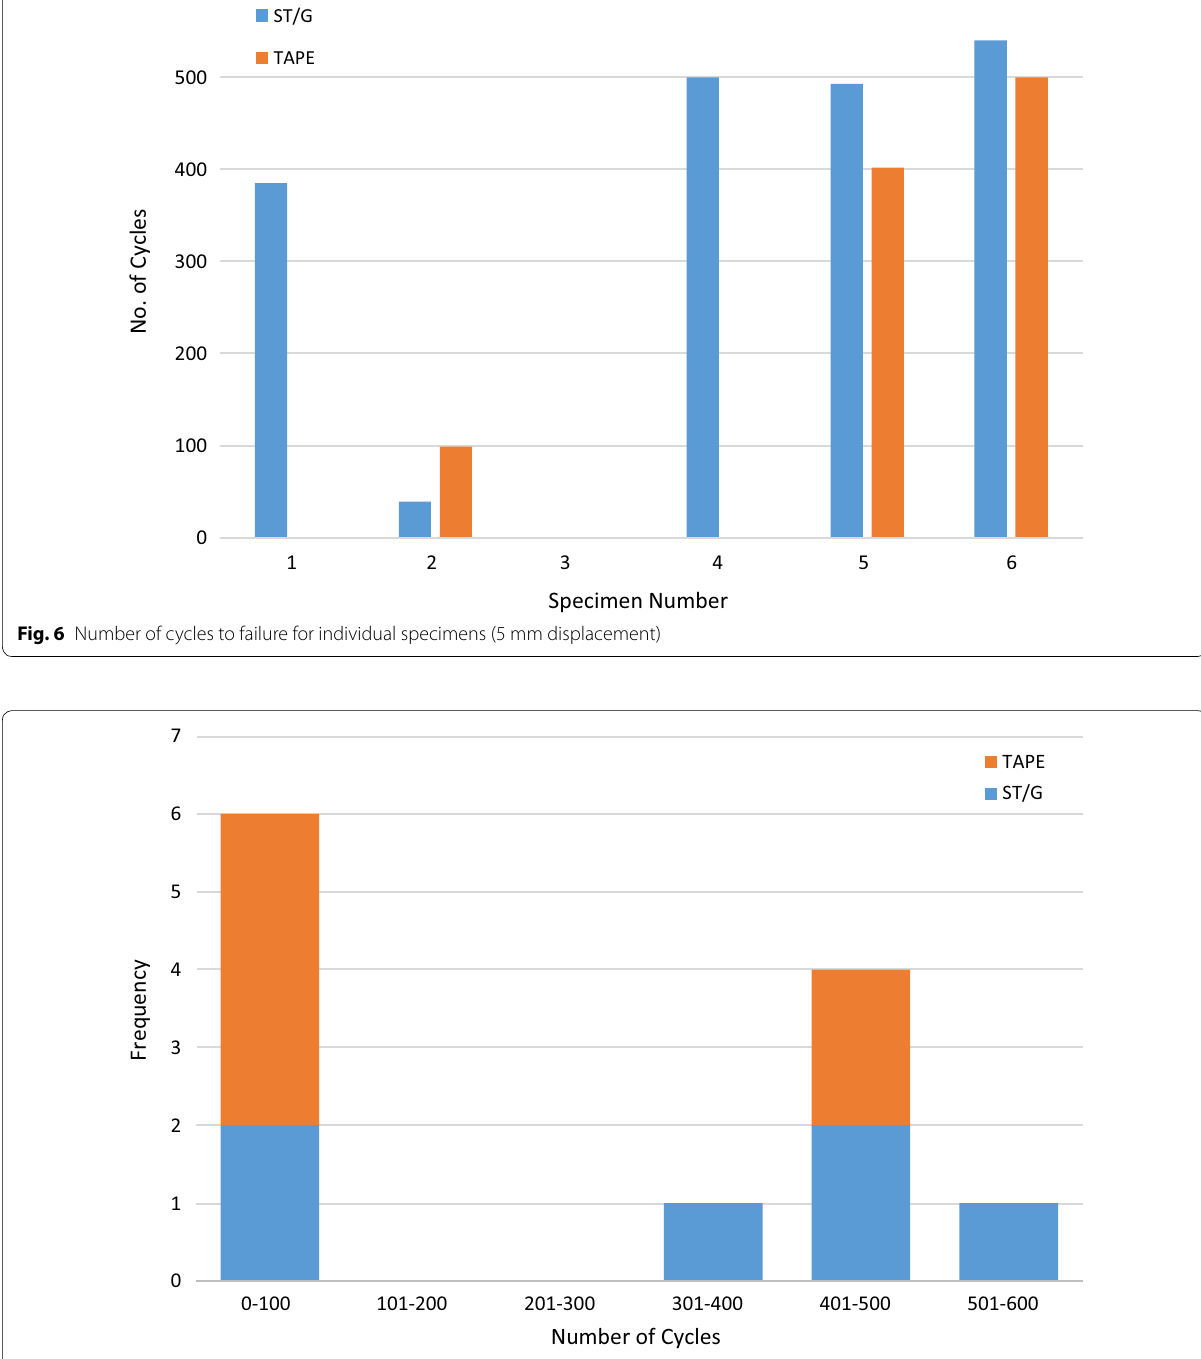
Fig. 7 Histogram of number of cycles to failure for all specimens (5 mm